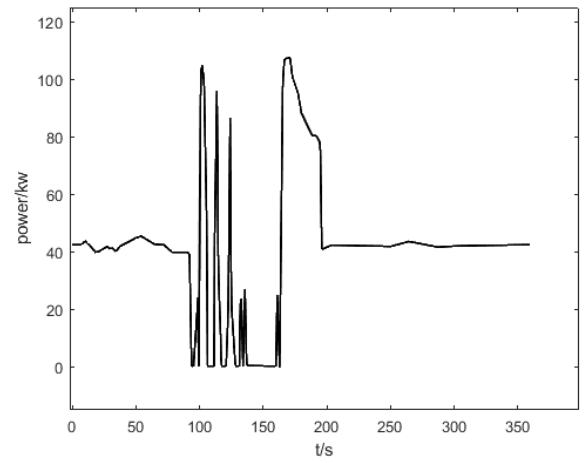
Figure 1. Typical operating mode curve of “Alsterwasser”.